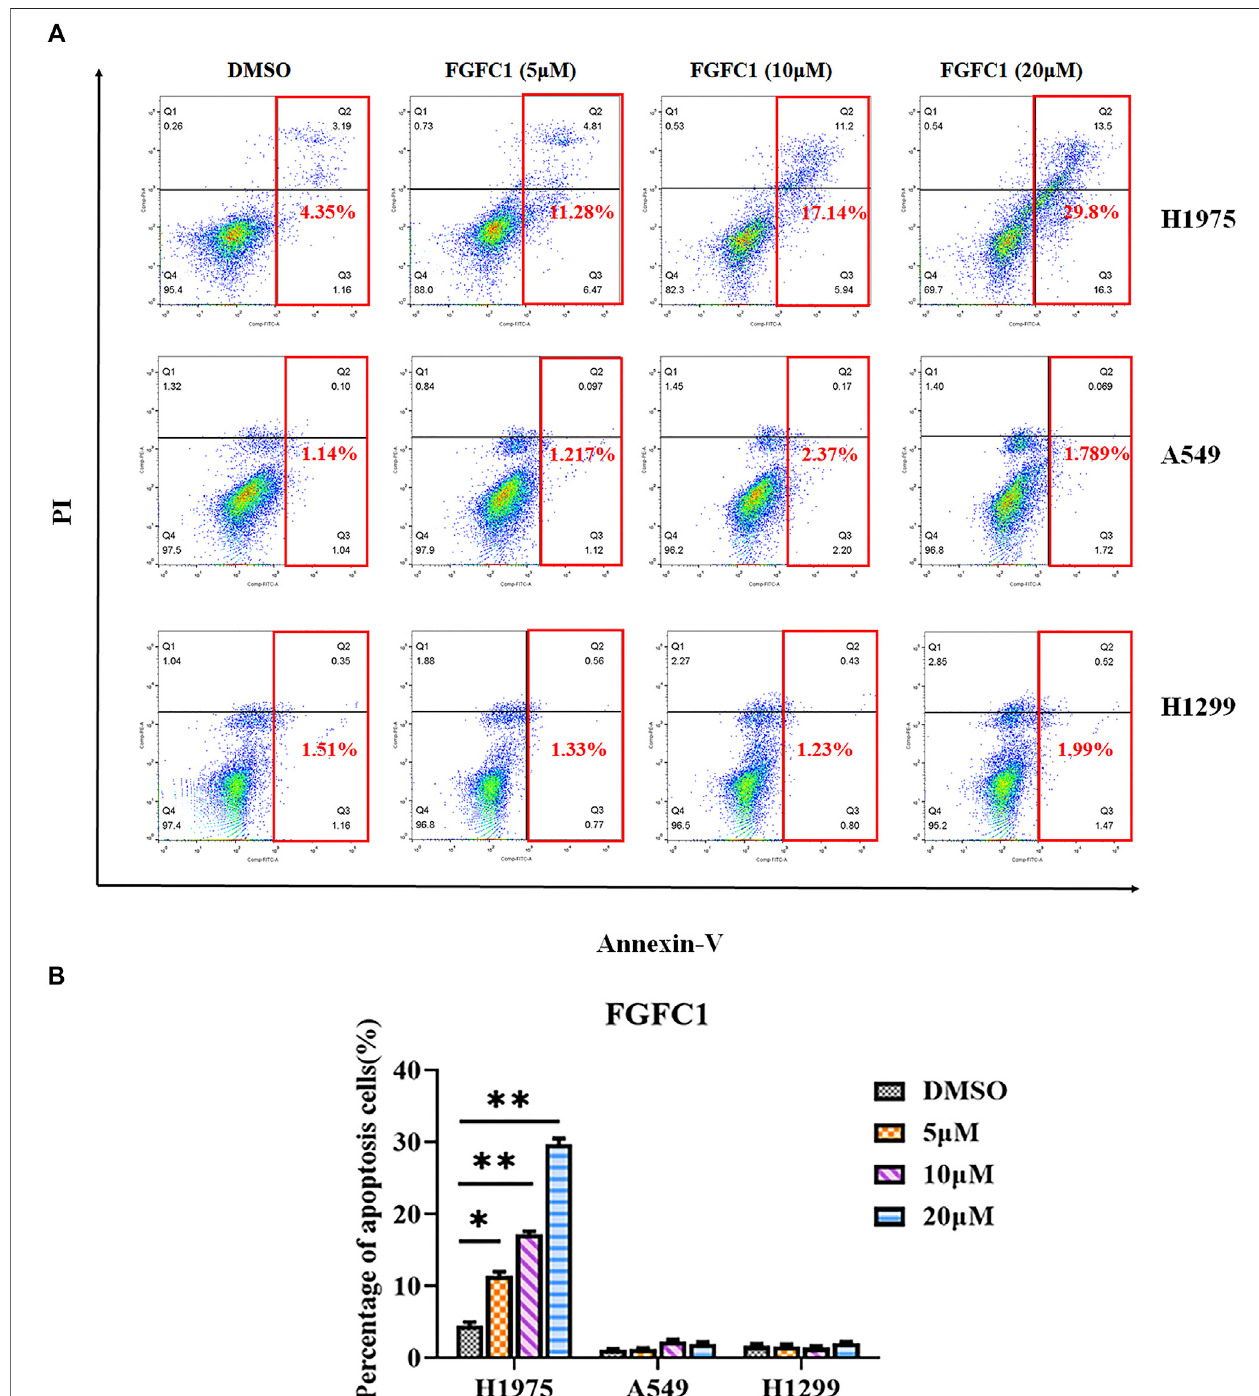
FIGURE2| FGFC1selectivelyinducedapoptosisinerlotinib-resistantNSCLCcells. (A) FGFC1signi fi cantlyenhancedH1975cellsdeath.H1975,A549andH1299 cells were incubated with the indicated concentrations of FGFC1 (0, 5, 10, and 20 μ M) for 48 h, and the cell apoptosis rates were detected by the Annexin-V FITC/PI staining assay. (B) The statistical result of (A) . (C) H1975, A549 and H1299 cells were treated with different concentrations of FGFC1 (0, 5, 10, and 20 μ M) for 24 h. Cleaved-PARP, cleaved-caspase 3, Bax and Bcl-2 protein levels were examined by Western blotting. β -actin were detected as the endogenous loading control, accordingly. (D) The statistical result of (C) . All data were represented as the means ± SD for at least three independent experiments ( *p < 0.05 and **p < 0.01 vs the DMSO control).